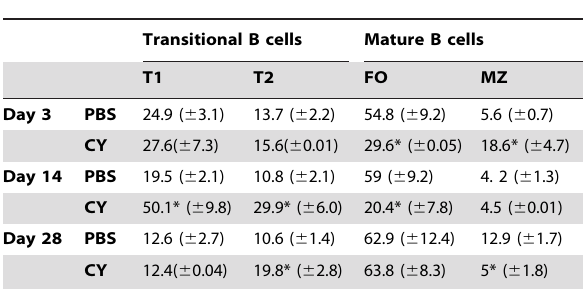
Table 2. Percentage of splenic B cells during